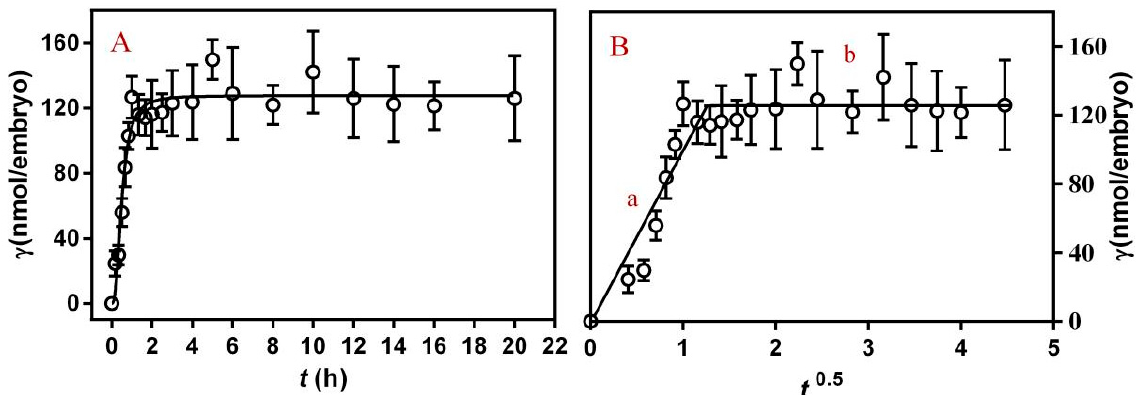
Figure 1. Adsorption kinetic ( A ) and diffusion control kinetic model ( B ) of PFLX (1.00 mM) on embryos ( n = 5) after incubation at different times at 25 °C, a: diffusion stage; b: transfer stage.